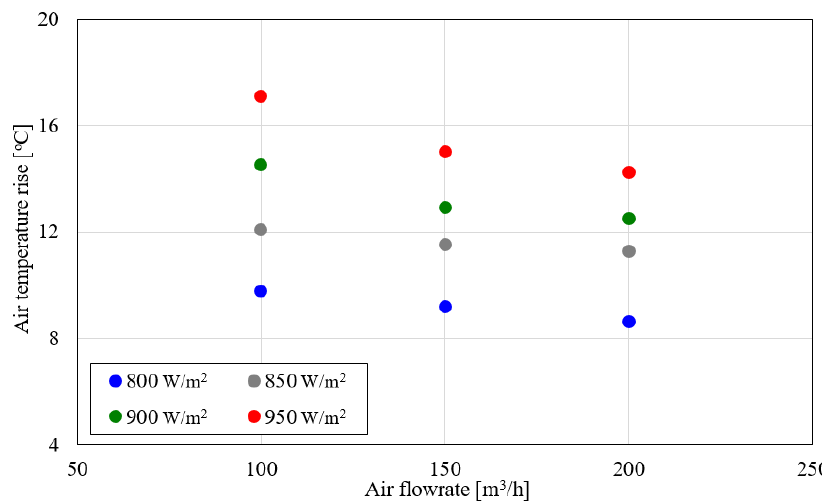
Figure 6. Effect of the air flowrate on the air temperature rise.